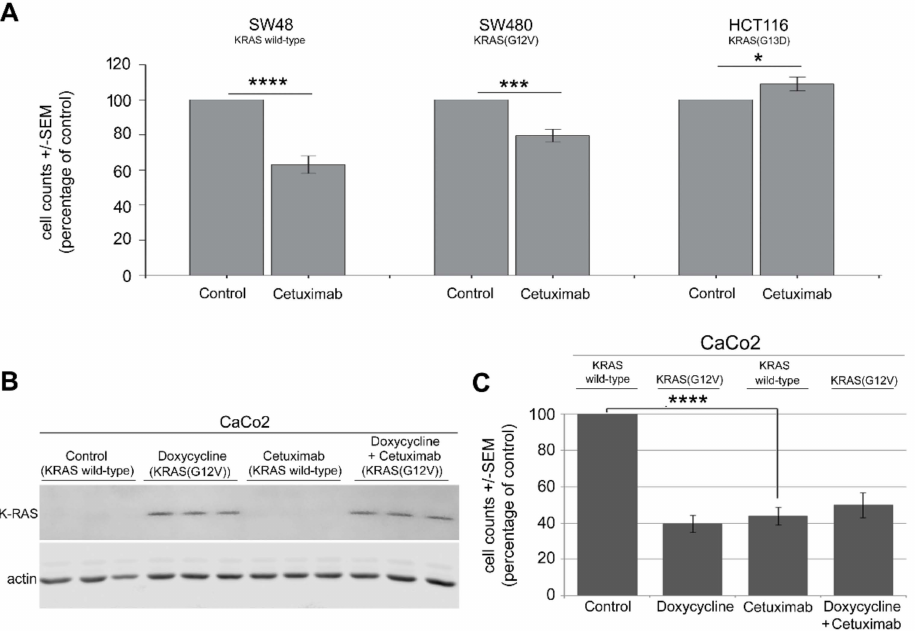
Figure 1. Mutation in KRAS gene diminishes the antiproliferative e ff ect of cetuximab in colorectal cancer (CRC) cells. ( A ) KRAS wild-type SW48, KRAS(G12V)-mutated SW480 and KRAS(G13D)-mutated HCT116 cells, ( B , C ) KRAS wild-type CaCo2 cells with doxycycline-inducible KRAS(G12V) were treated with cetuximab (100 ng / mL) for 72 h, and a proliferation assay was performed. Asterisks indicate a statistically significant antiproliferative e ff ect of cetuximab normalized to 1 in nontreated controls (* p ≤ 0.05, *** p ≤ 0.0001 and **** p ≤ 0.00001; 9 data points from three biologically independent experiments in SW48 and HCT116 cells; and 11 data points from two biologically independent experiments in SW480 cells). Western blot data show the expression of KRAS(G12V) 24 h after treatment with doxycycline. Actin was detected as a loading